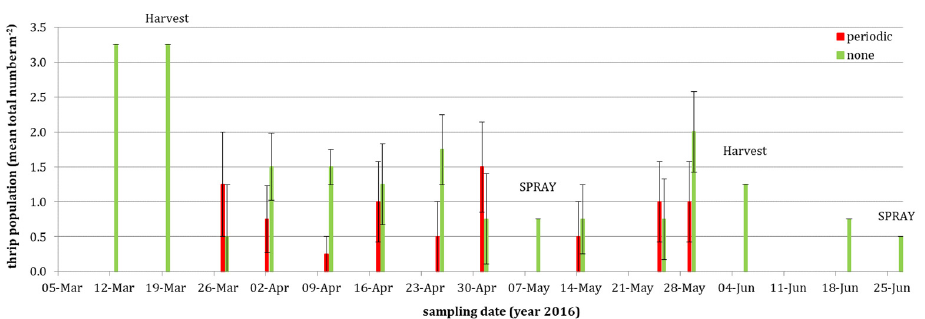
Figure 7. Population (expressed as mean total number per m 2 ) of thrips found in the plots of the meadow within the vineyard under the no- and periodic-harvest treatments from 12 March to 26 June in 2016.